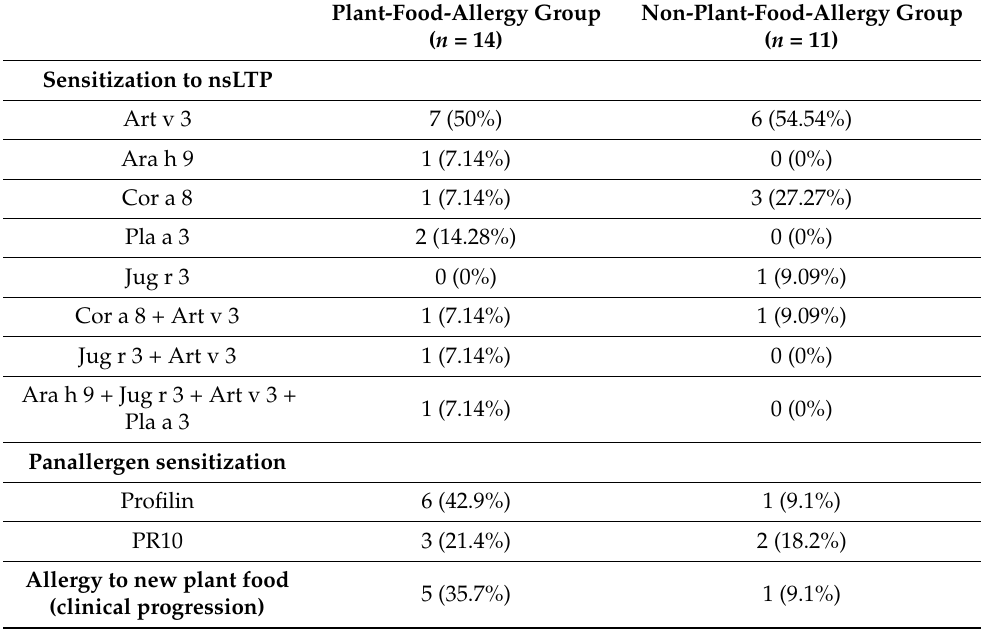
Table 3. Characteristics of patients non-sensitized to Pru p 3 ( n =